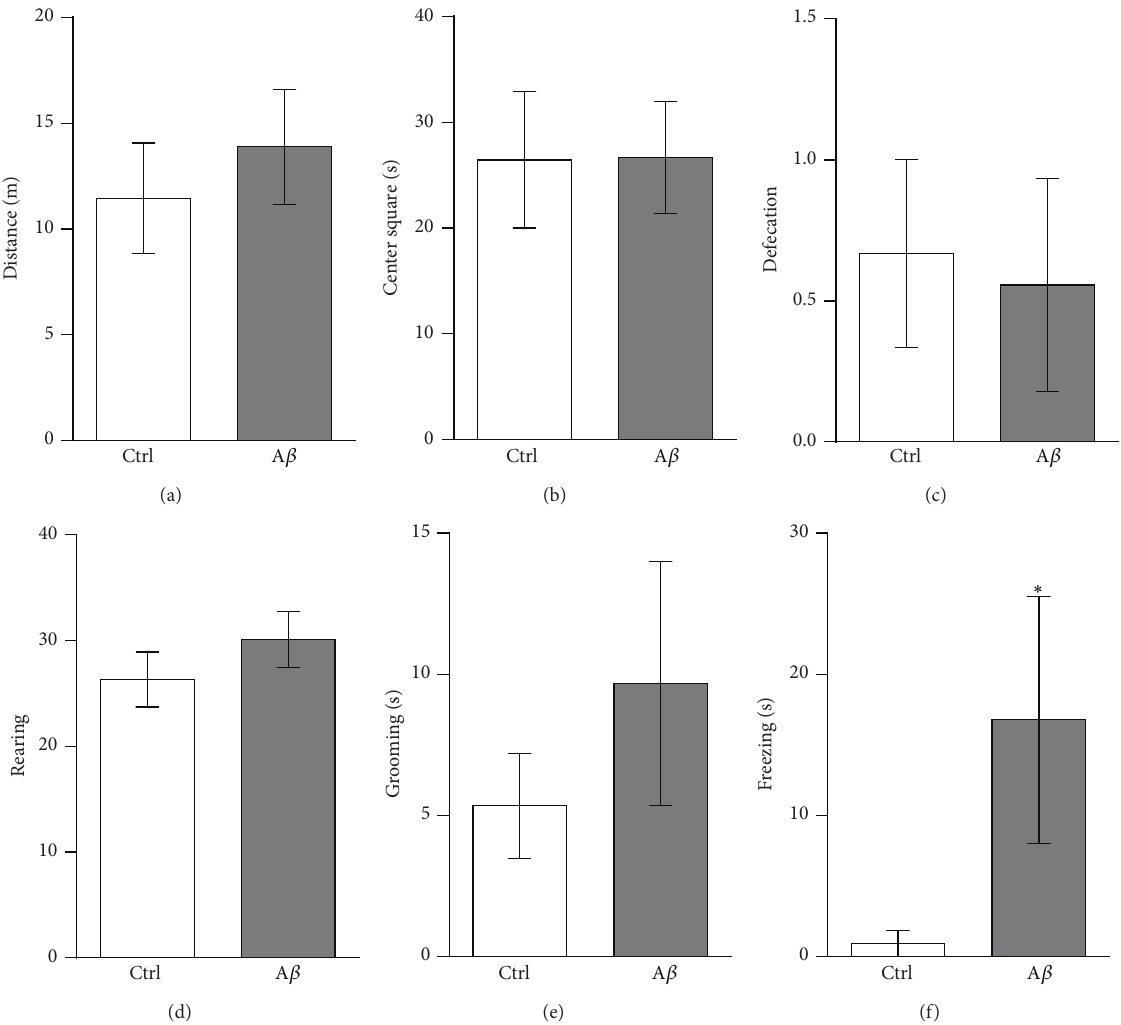
Figure 6: A 𝛽 induces mild anxiety. (a)–(f) Quantifications of anxiety-related behaviors evaluated during the 5 min test in the open field arena. Such measurements included (a) the distance traversed; (b) the time spent in the arena’s center; (c) the defecation frequency; (d) the amount of rearing; (e) the time spent grooming and (f) freezing. Note that the only parameter that significantly increased in A 𝛽 -treated animals is the duration of the freezing behavior. Data are presented as means ± S.E.M. ∗ 𝑝 < 0.05 versus